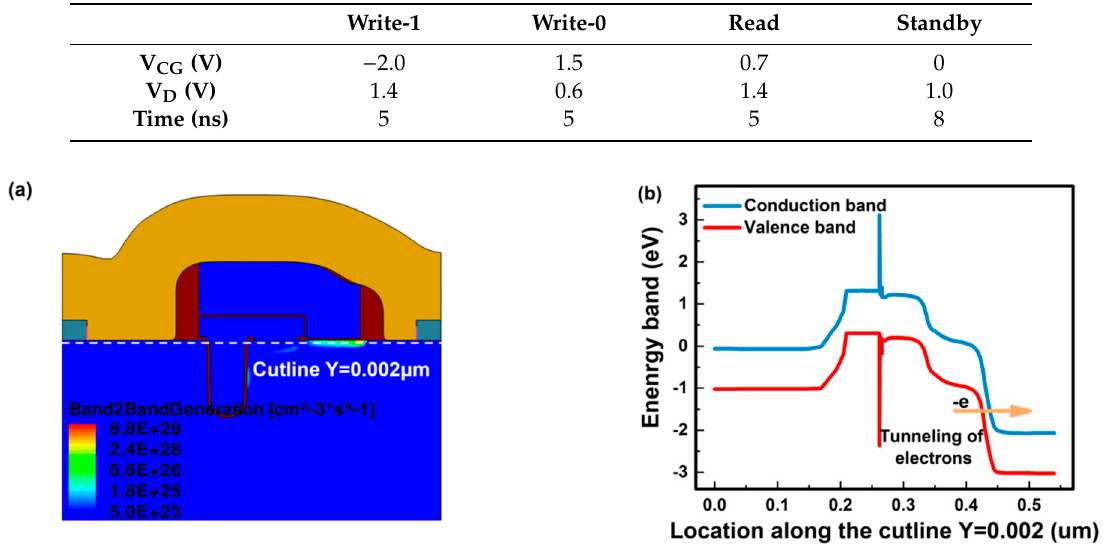
Figure 2. ( a ) Contour of the band-to-band tunneling generation rate of the embedded field-effect transistor (TFET) during the write-1 operation; ( b ) Energy band diagrams along the horizontal cutline Y = 0.002 μ m shown in (a). The band-to-band tunneling occurs in the place where the band bending is strongest that electrons tunnel from the valence band of the inverted channel to the conduction band of the n+ drain region.